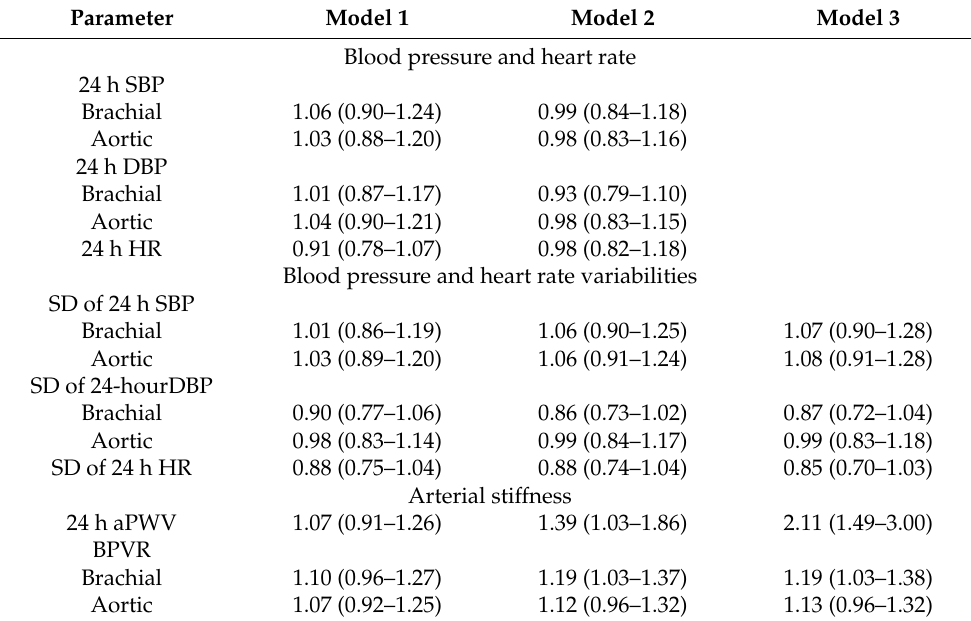
Table 4. Hazard ratios for 1 SD change of 24 h blood pressures, 24 h heart rate, blood pressure and heart rate variabilities, aortic pulse wave velocity (aPWV), and blood pressure variability ratio (BPVR) in relation to the combined endpoint of death or